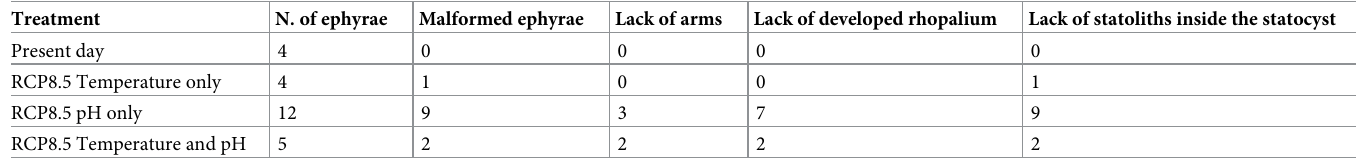
Table 5. Number of ephyrae analyzed per treatment, malformed ephyrae and the different kinds of malformations observed (lack of arms, lack of well-developed rhopalium and lack of statoliths inside the statocyst). Treatment N. of ephyrae Malformed ephyrae Lack of arms Lack of developed rhopalium Lack of statoliths inside the